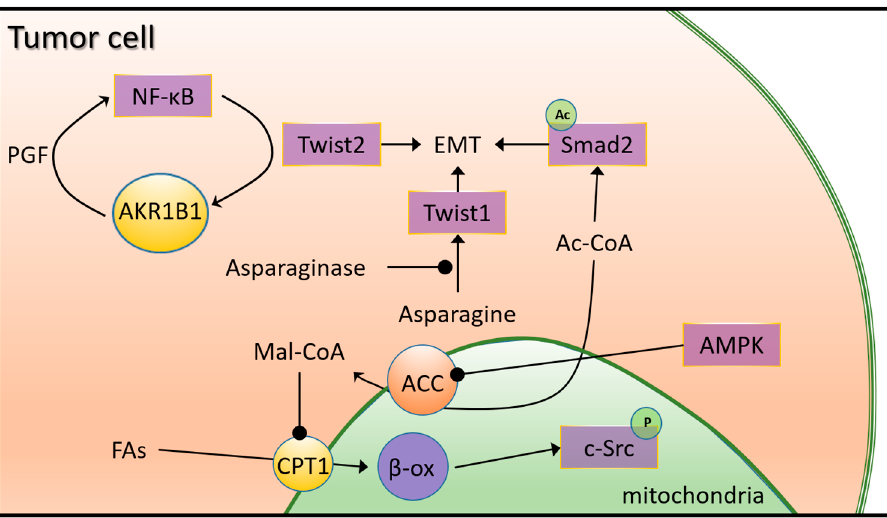
Figure 5. Lipid metabolic reprogramming in TNBC. The key lipogenic enzyme acetyl-CoA carbox- ylase (ACC) irreversibly catalyzes acetyl-CoA to malonyl-CoA in the mitochondrial membrane, which is an inhibitor of CPT1 and FAO. FAO flux in TNBC is promoted by downregulated ACC, which may also be caused by AMPK (AMP-activated protein kinase) signaling. The resulting increase in cellular acetyl-CoA promotes EMT-inducing Smad2 (SMAD Family Member 2) acetylation and ultimately, activation of EMT pathways and metastasis. Upregulated AKR1B1 in TNBC activates the NF- κ B (nuclear factor kappa B) signaling through its accumulated metabolite PGF, which leads to the overexpression of Twist2 and enhances cancer stem cell (CSC) properties in TNBC. Higher asparagine levels are associated with less metastatic potential in TNBC by activation of Twist1 molecule through downregulation of the inhibitor asparaginase. Fa tt y acid cells supplying bioenergy may be derived also from triglycerides in circu- lating lipoprotein particles. Upregulation of lipoprotein lipase (LDL), which hydrolyzes triglyceride into fa tt y acids and proteins in the fa tt y acid binding protein (FABP) family,